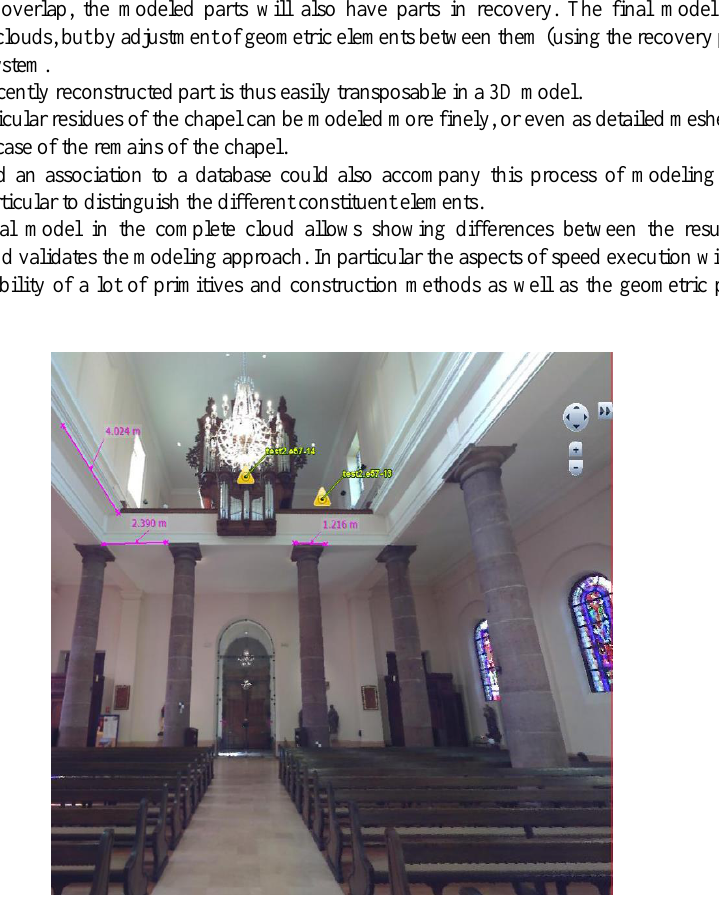
Fig. 2: Church interior as point cloud with measurement functions